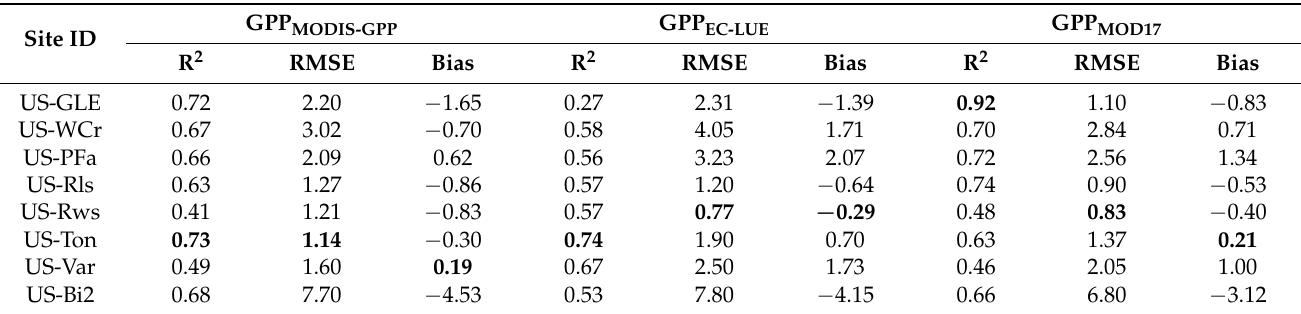
Table 5. Coefficient of determination (R 2 ), root mean square error (RMSE, gC/m 2 /d) and bias (gC/m 2 /d) for GPP MODIS-GPP , GPP EC-LUE , GPP MOD17 and GPP EC